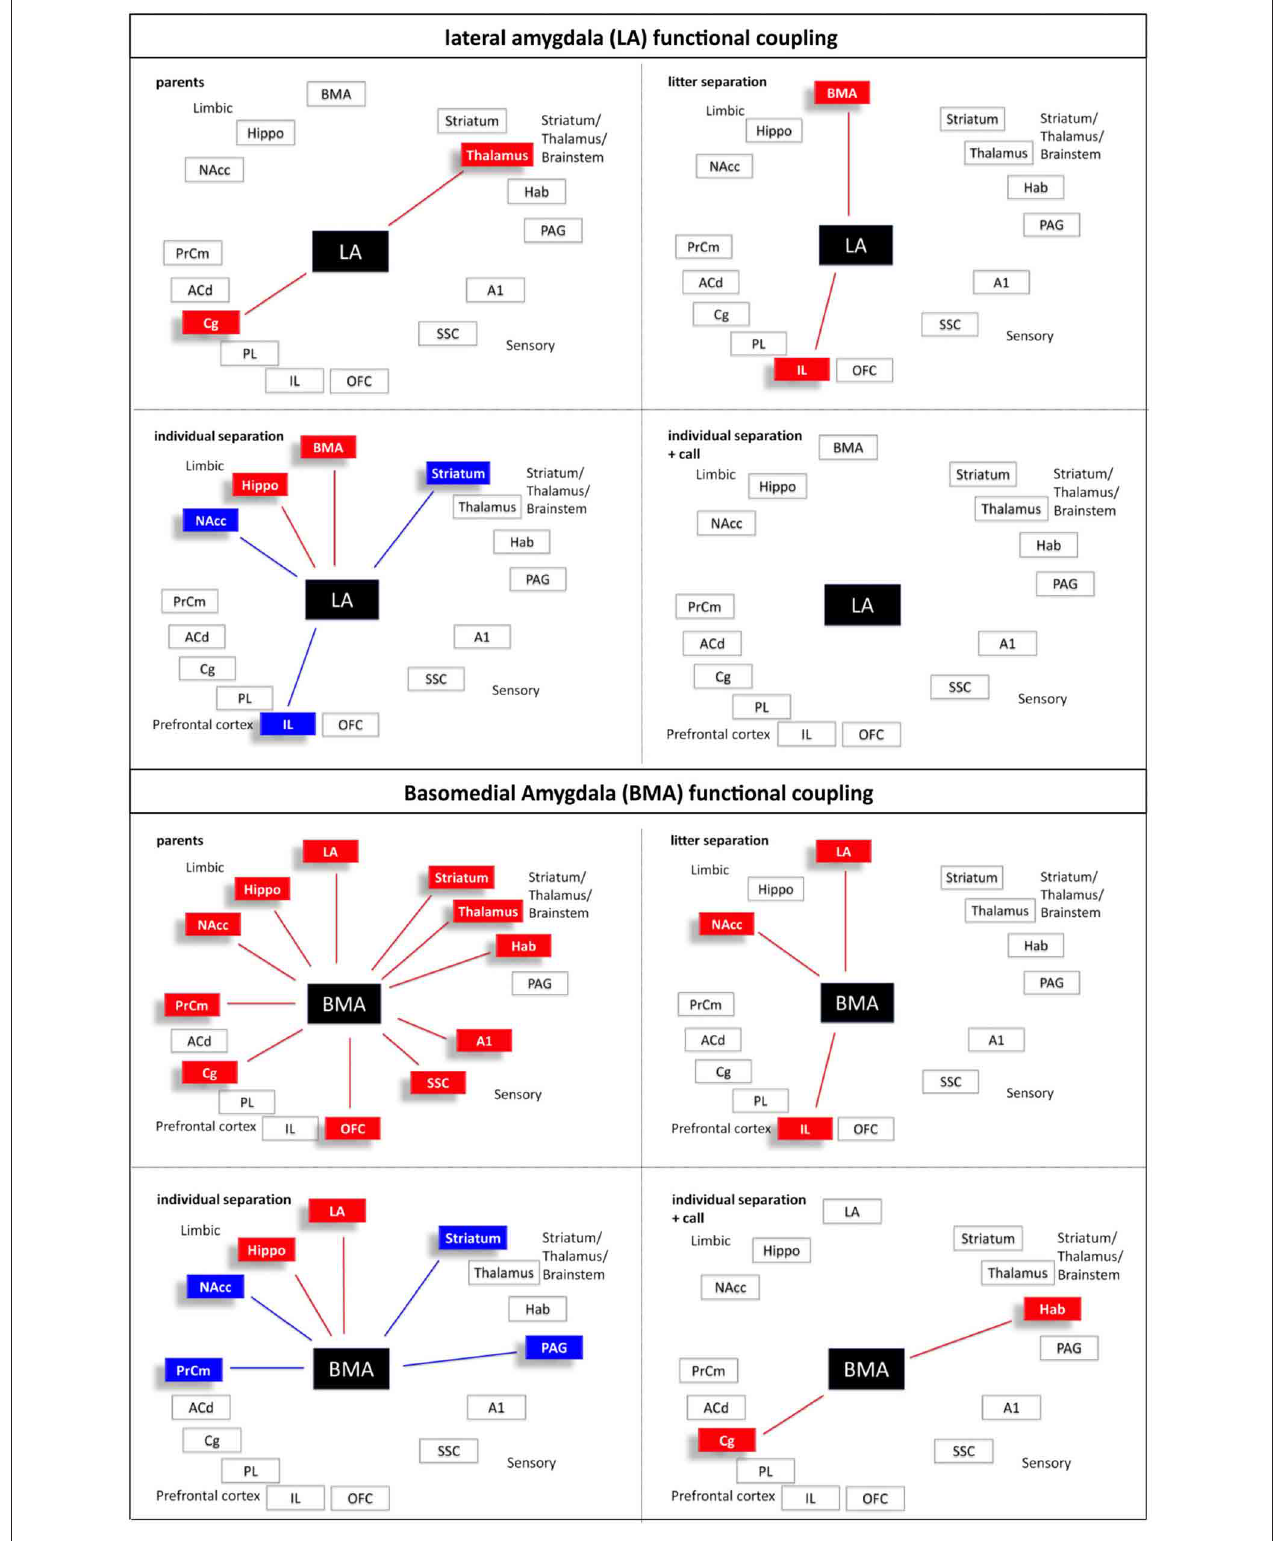
FIGURE 9 | Interregional functional coupling of the lateral (LA) and basomedial (BMA) amygdala under different stress conditions. Red color indicates positive, blue color indicates negative correlations ( p < 0 . 05).